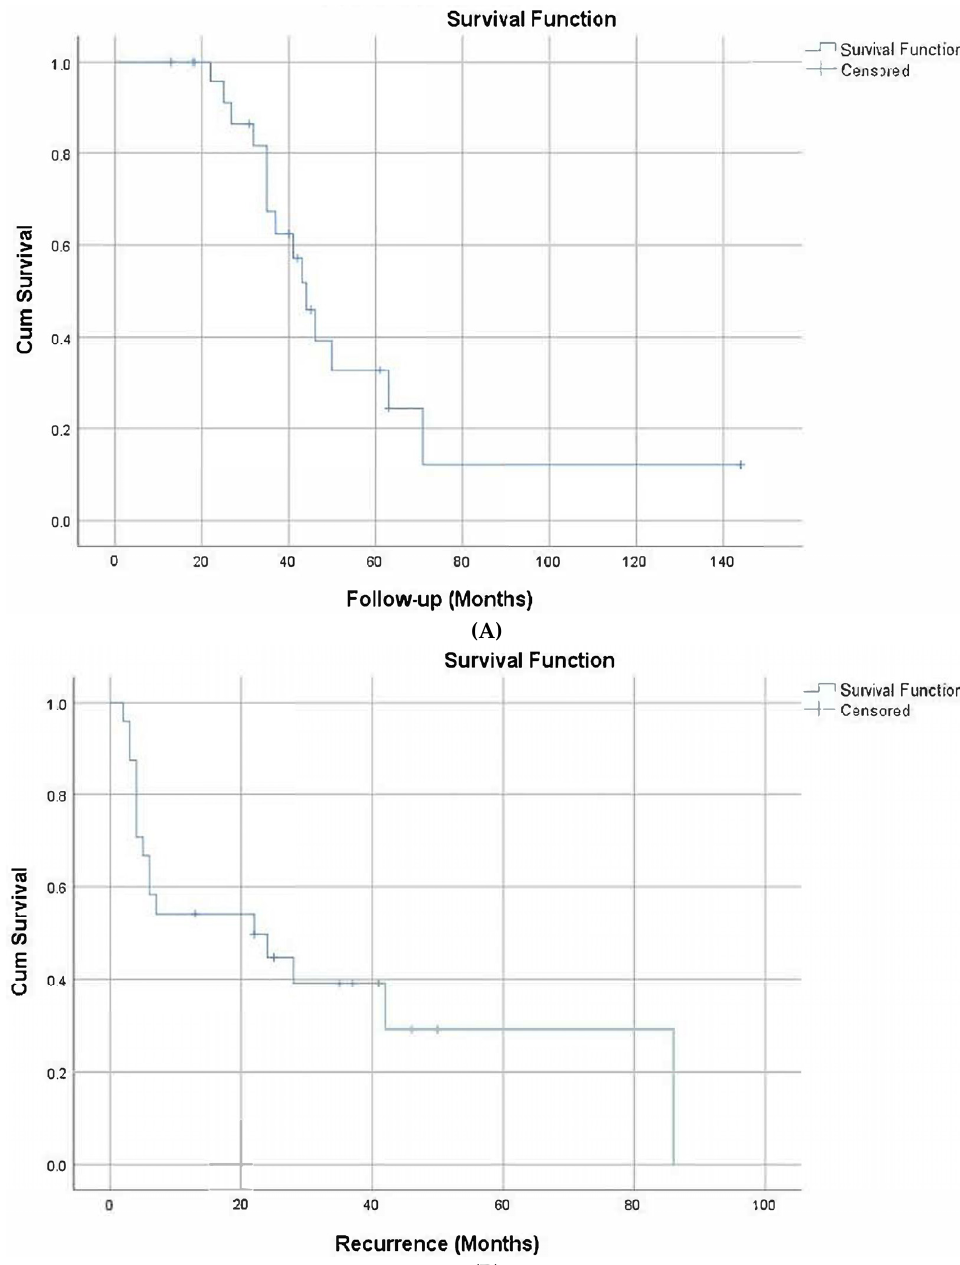
Figure 1. Overall survival ( A ) and disease-free survival ( B ). The mean time from diagnosis to relapse was 21 months. After treatment with GO, 16.67% ( n = 4) of patients achieved a morphologic leukemia-free state (MLFS), 37.5% ( n = 9) achieved CR (complete remission), while 45.83% ( n = 11) had progressive disease (PD). The overall response rate was 54.1%. Two of the patients who achieved a response later relapsed. Twelve (50%) patients underwent HSCT. The most common causes of death were infections. The causes of mortality are shown in Table 4.